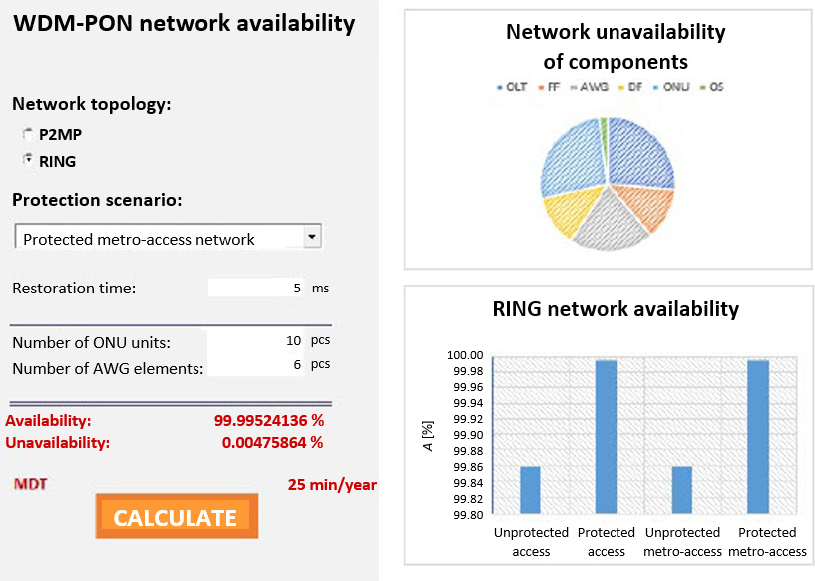
Figure 5. The main screen’s part for the protected RING metro-access WDM-PON network.